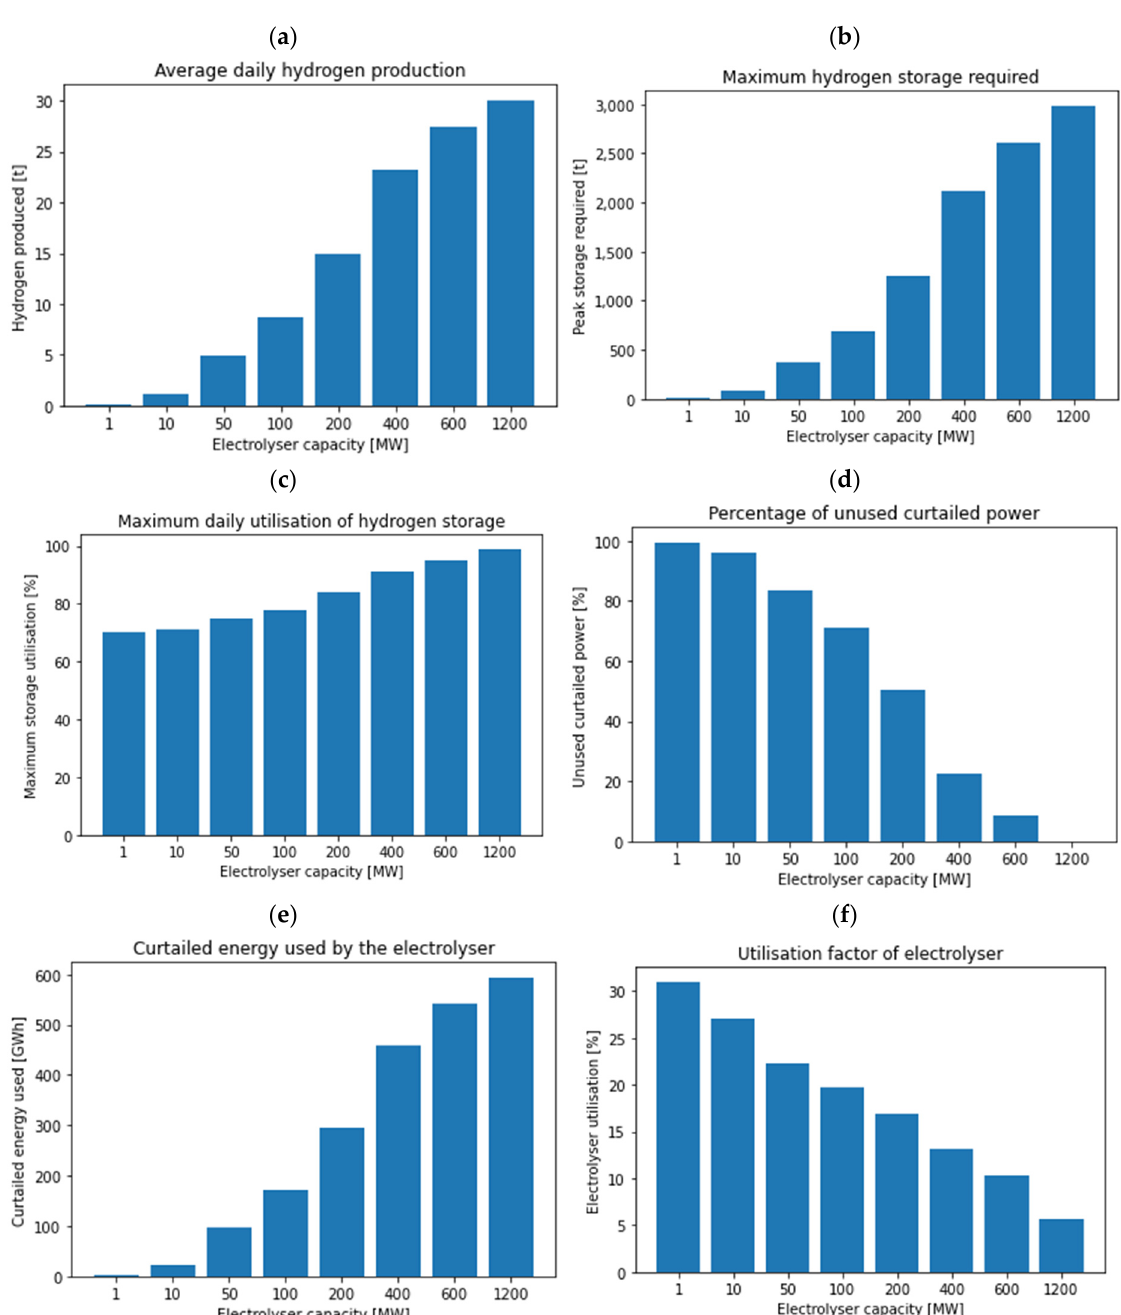
Figure 8. Potential hydrogen production using curtailed wind power in 2020 (EirGrid data). ( a ) Average daily hydrogen production; ( b ) maximum hydrogen storage required; ( c ) maximum daily utilization of hydrogen storage; ( d ) the percentage of unused curtailed power; ( e ) curtailed energy used by the electrolyzer, and ( f ) utilization factor of electrolyzer.